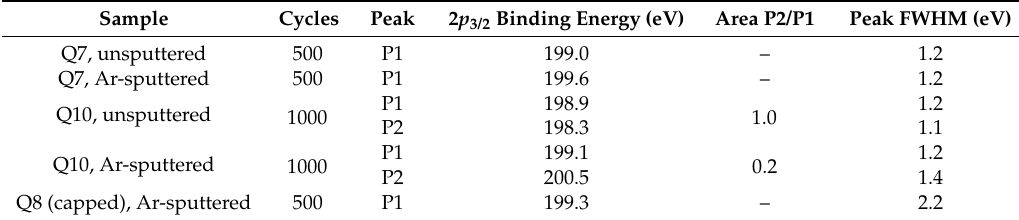
Table 4. Components of Cl 2 p XPS peaks.